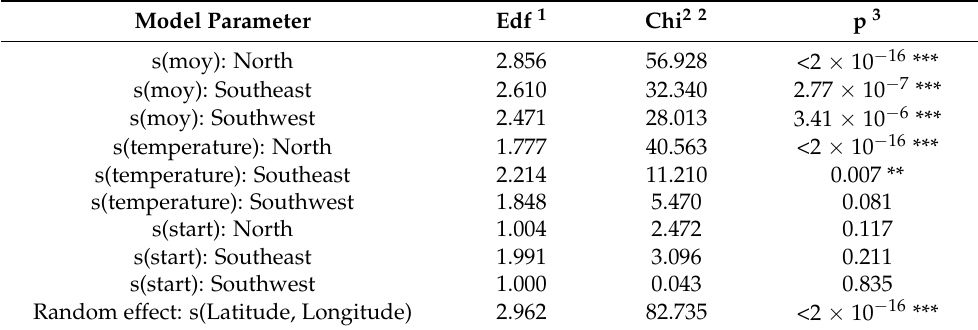
Table 2. Statistics of model parameters for the model explaining the number of observations during the transect walk.